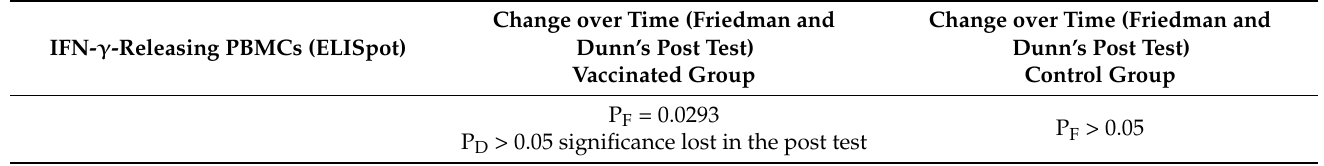
Table A3. Results of the Friedman and Dunn’s post test of IFN- γ -releasing PBMCs in vaccinated and control cats after FCV Vaccination I measured by ELISpot.